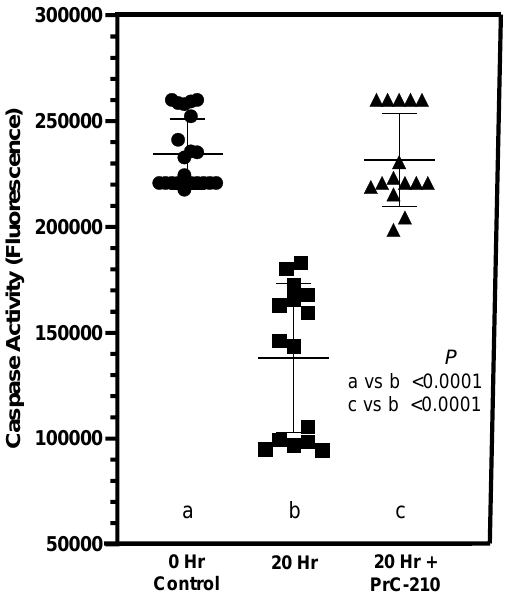
Figure 5. Caspase activity in post-transplant kidneys. Kidney supernatant activated caspase activity was measured enzymatically as described in Materials and Methods in a 60 min reaction. a,b,c designations are used to enable statistical comparisons between groups.